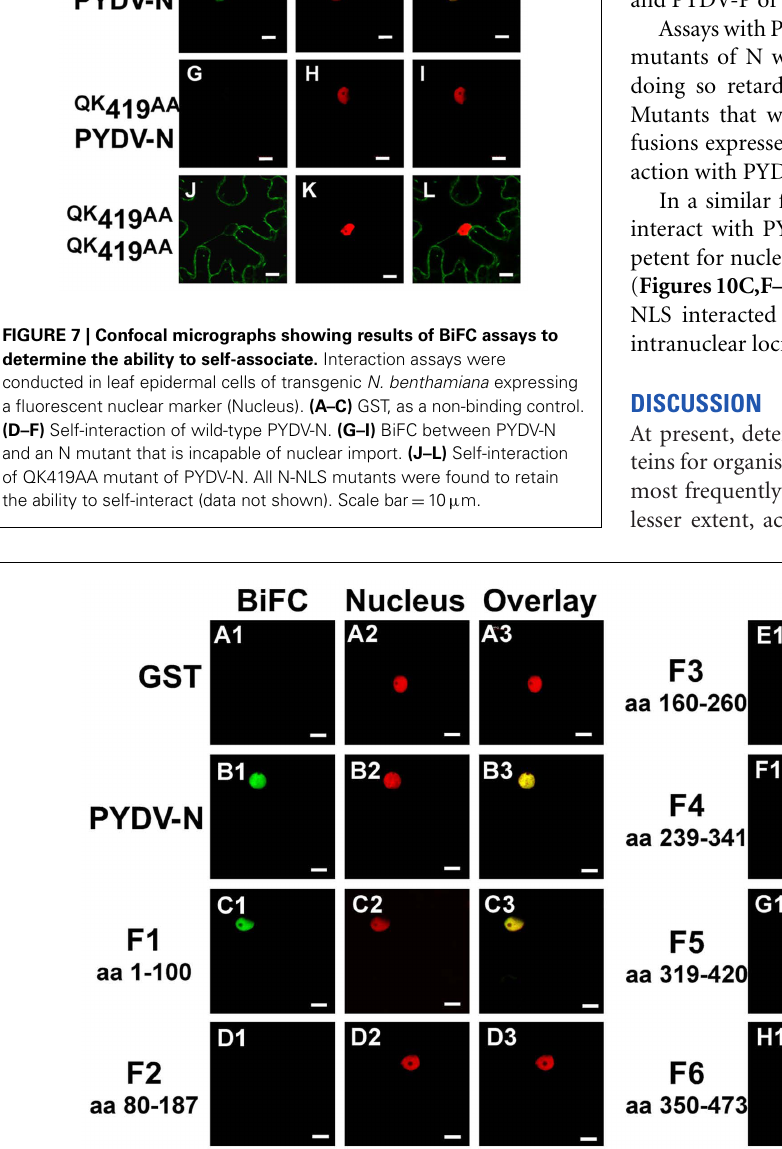
PYDV-N to interact with wild-type N protein in BiFC assays. (A1–A3) GST. (B1–B3) Wild-type PYDV-N. (C–H) BiFC between PYDV-N and PYDV-N fragments F1–F6.The portions of PYDV-N used in the BiFC assays are indicated by the amino acid (aa) designation for each panel. Scale bar = 10 μ